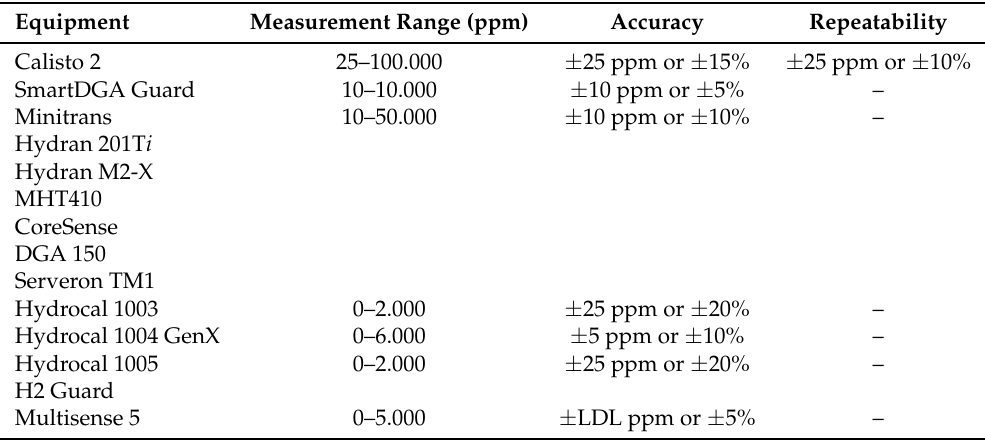
Table 8. Carbon monoxide concentration measurement range and accuracy of fault detection monitors (as indicated by manufacturers).